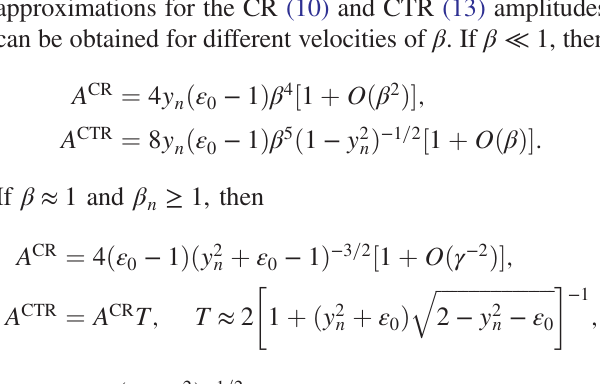
5 = ω ; n = 1, x p r r ¼